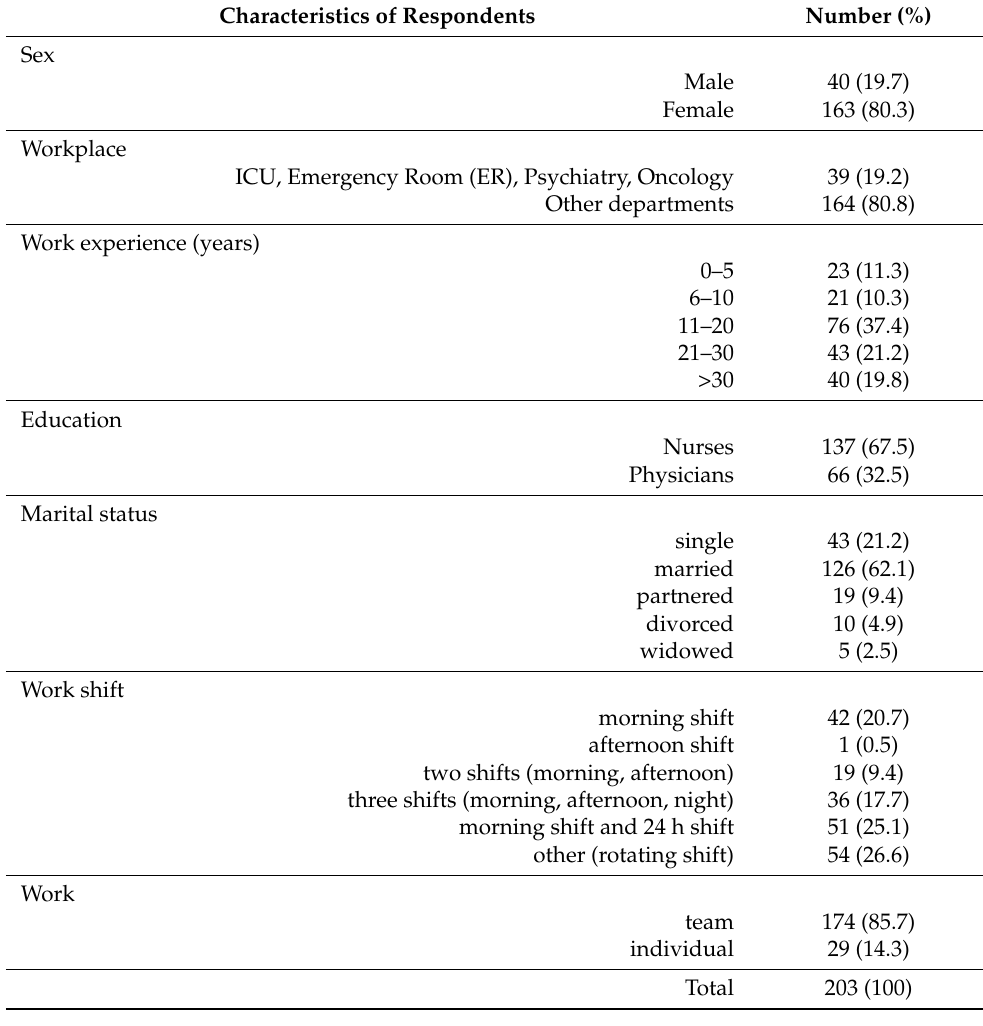
Table 2. Sociodemographic Characteristics of Respondents ( n = 203).